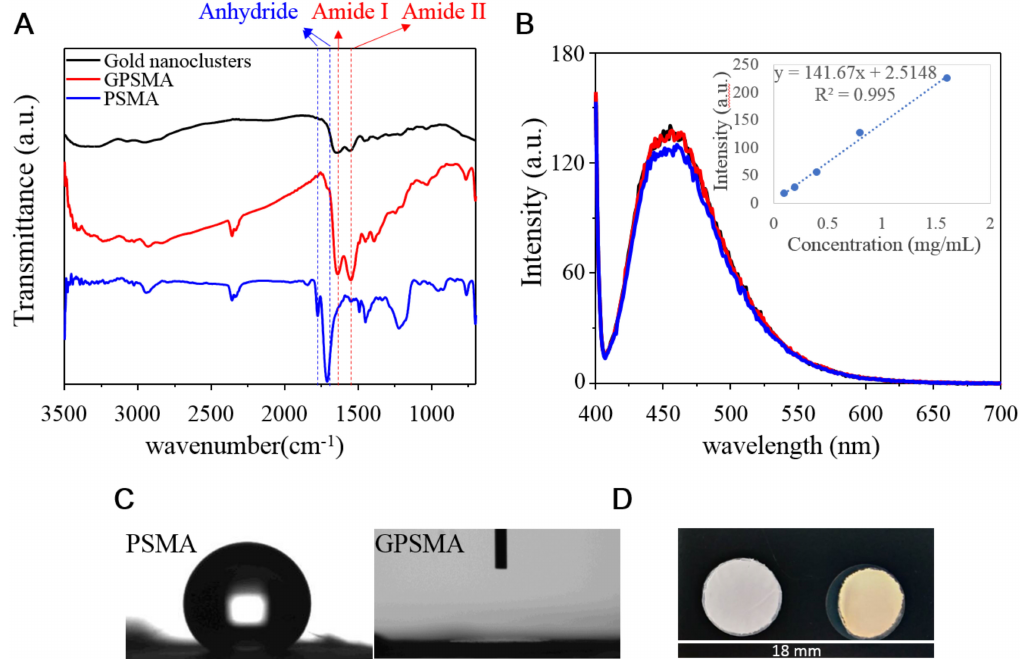
Figure 3. Assessments of the physicochemical properties of GPSMA. ( A ) FTIR spectra of QG, PSMA, and GPSMA; and ( B ) fluorescence spectra of free QG in aqueous solution after modifying the PSMA, with the measurements performed using an excitation wavelength at 390 nm. ( C ) Water contact angle measurements and ( D ) a macroscopic view showing the exterior changes of PSMA and